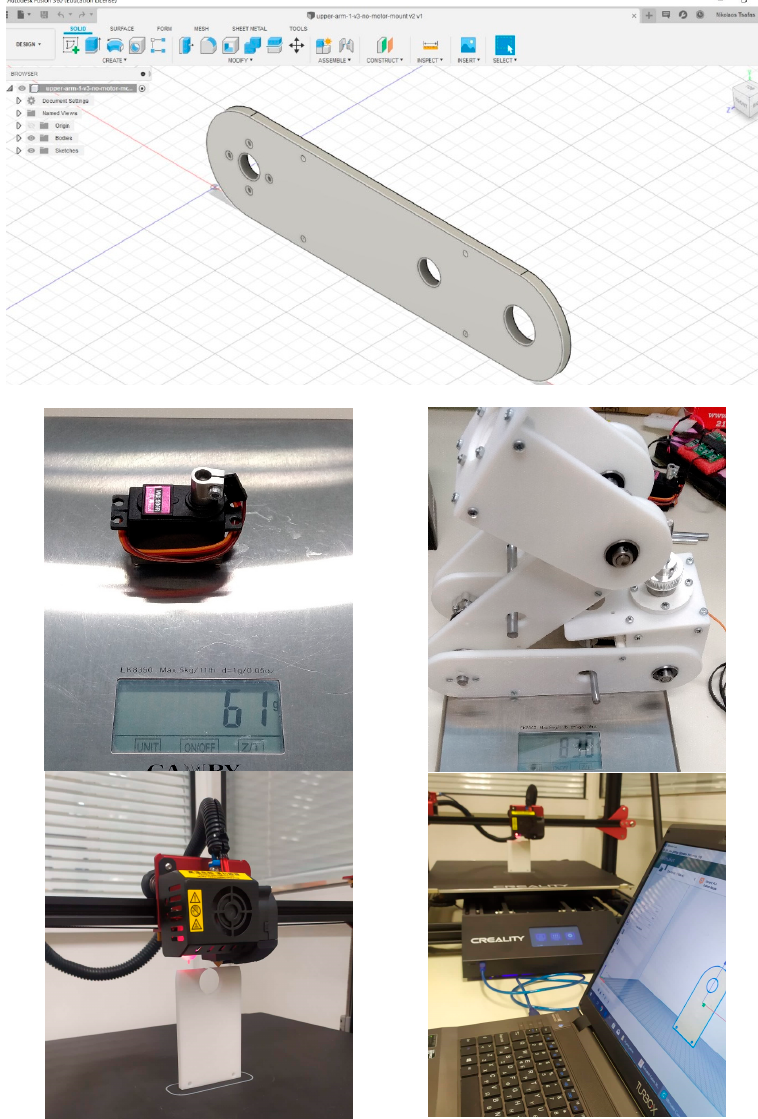
Figure 6. 3D printed parts of the arm manipulator (process and weight) .